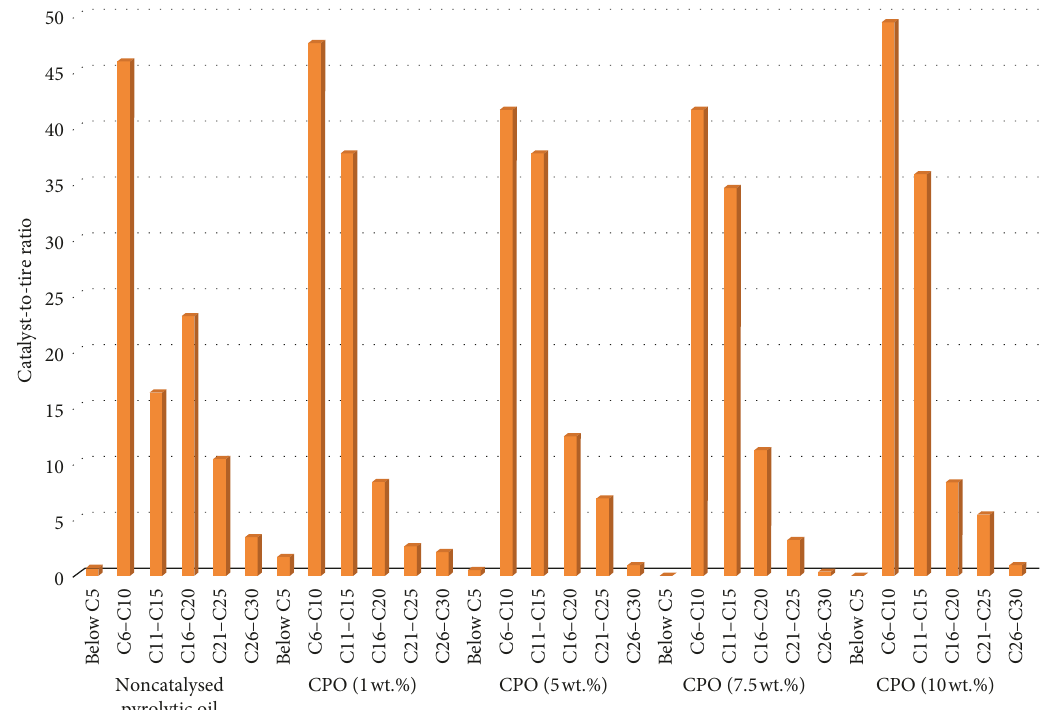
Figure 6: Effect of catalyst from GC-MS on carbon range in pyrolytic